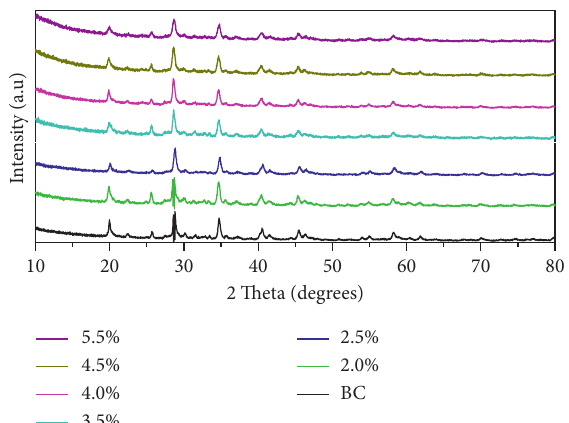
Figure 1: Powder XRD patterns of BaAl phosphors and the JCPDS cards.